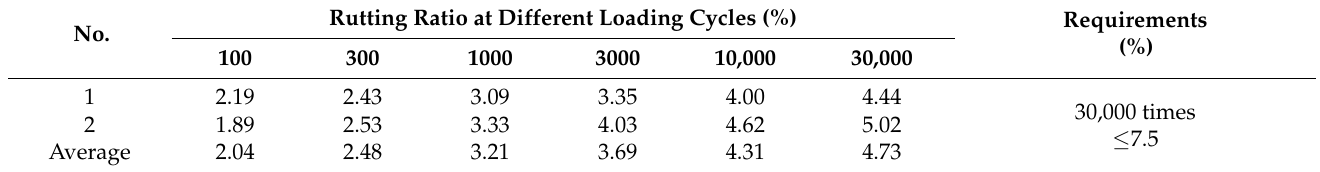
Table 9. Results of the French rutting test.